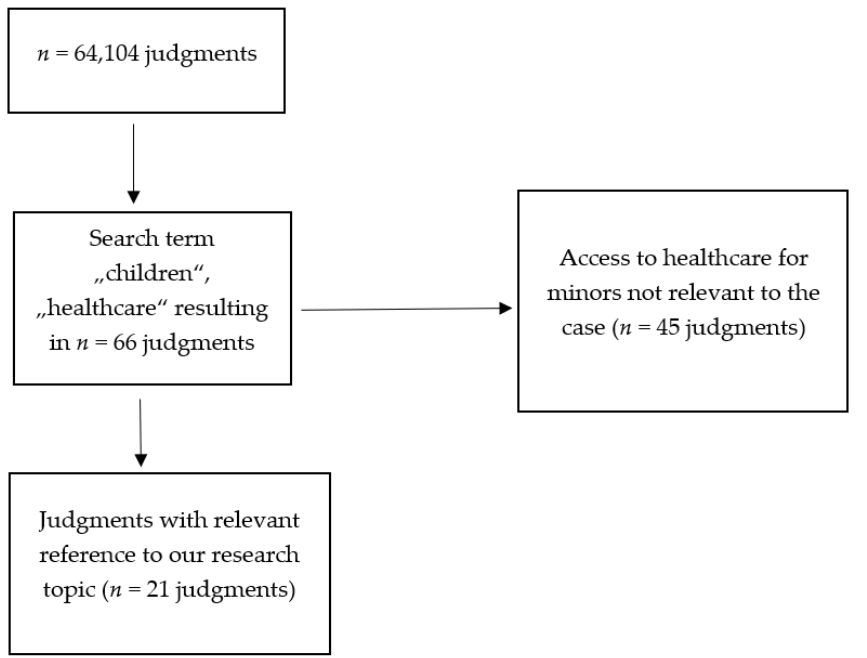
Figure 1. Flowchart of the search ( n refers to the size of sampled judgments) .